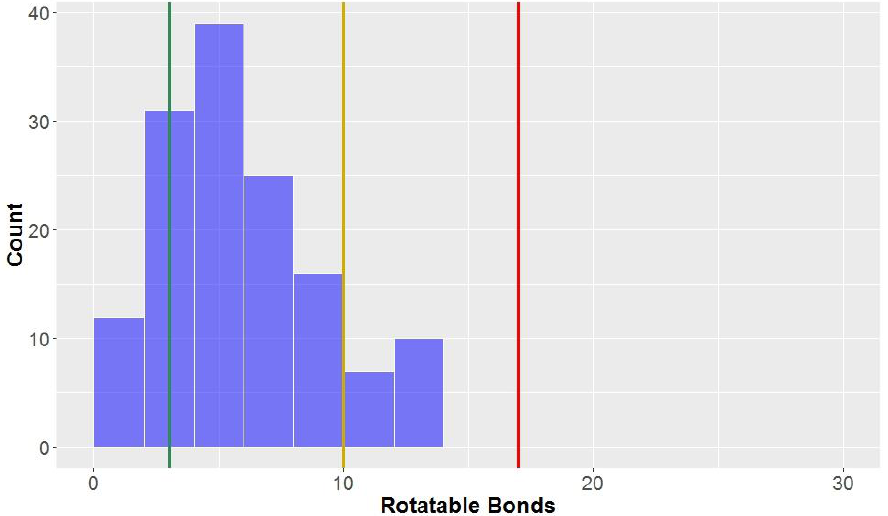
Figure 11. The statistical distribution of the rotatable bonds of the classical lignans and neolignans (green = 3, compounds < 3 are in the lead-like space; yellow = 10, compounds < 10 are in the drug-like space; red = 17, compounds < 17 are in the known drug space). Total number of compounds = 140.